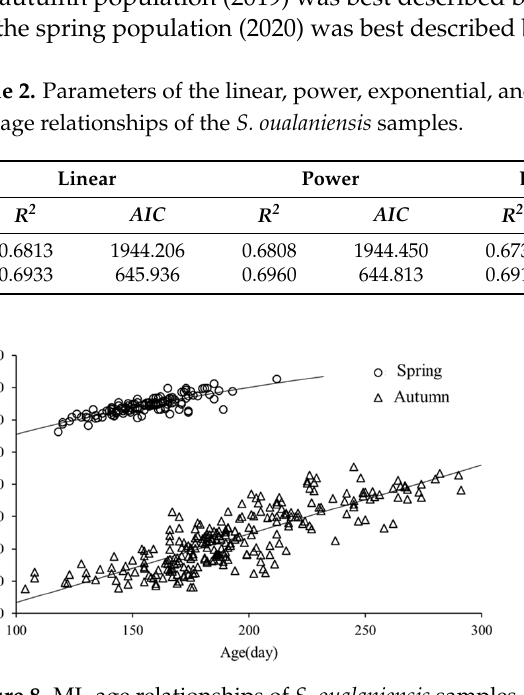
Figure 8. ML-age relationships of S. oualaniensis samples. ML-age growth model for the autumn population